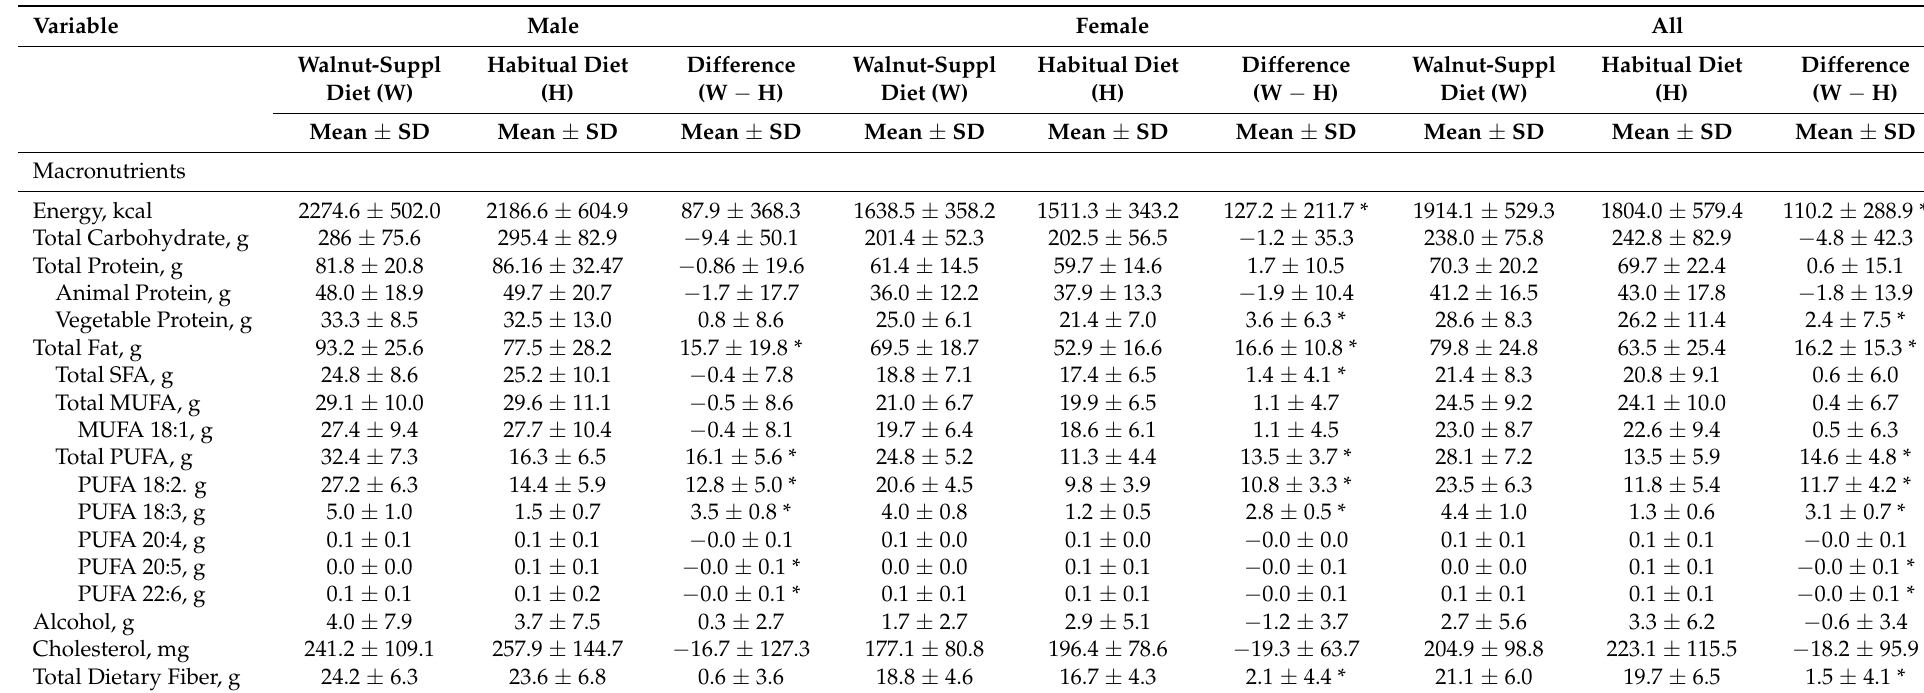
Table 2. Changes in the intake of selected macronutrients of 90 participants evaluated by seven 24 h recalls for each diet period.